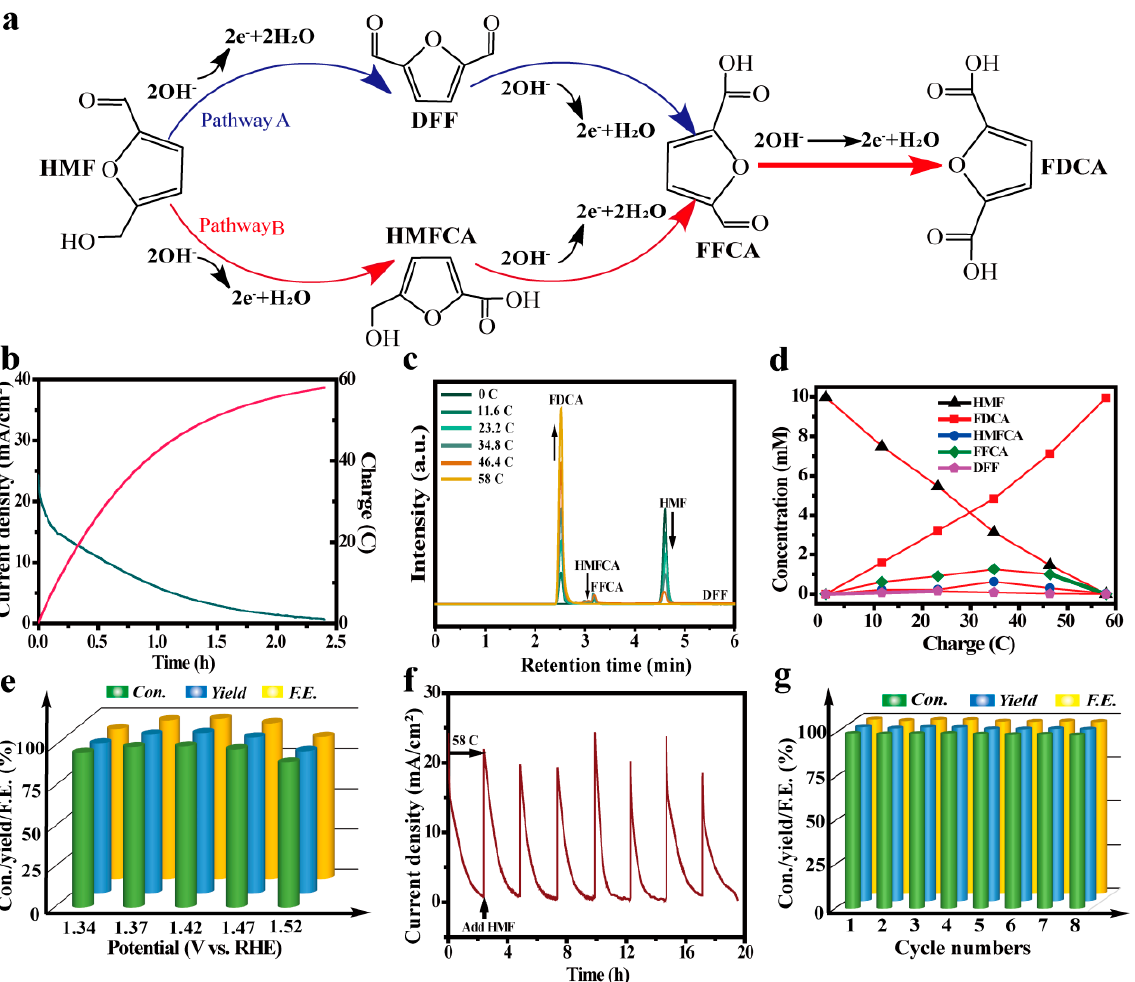
Figure 4. ( a ) Two possible pathways of HMFEOR to FDCA. ( b ) I − t curve for CoO–Co@C/CF at constant potential of 1.37 V vs. RHE in 1.0 M KOH with 10 mM HMF by passing the charge of 58 C. ( c ) HPLC traces of HMFEOR over CoO–Co@C/CF at 1.37 V vs. RHE in 1.0 M KOH with 10 mM HMF at various reaction times. ( d ) Concentrations of HMF, intermediates, and products during HMFEOR over CoO@C/CF. ( e ) HMF conversion, FDCA yield, and FE of HMFEOR at various potentials. ( f ) I − t curve of HMFEOR over CoO–Co@C/CF at 1.37 V vs. RHE with the intermi tt ent addition of 10 mM